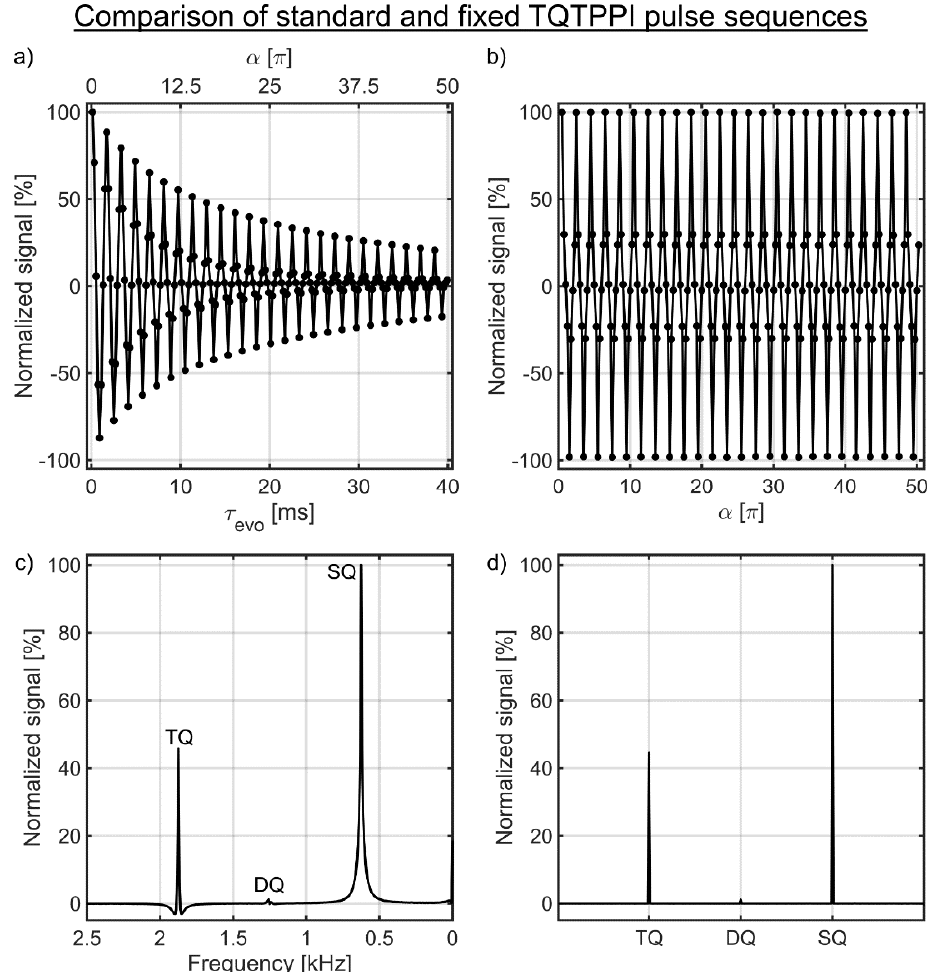
Figure 4. ( a , b ) show the standard and the fixed TQTPPI FID of the sample with 4% agarose in 134.75 mM NaCl, respectively. The corresponding standard and fixed TQTPPI spectrum are shown in ( c , d ), respectively. ( a ) The evolution time increment samples the TQ signal for a wide range of ion interaction strengths, which allows correcting the TQ signal for changes in the transverse relaxation times. The RF phase increment causes oscillations in the single-quantum (SQ) and TQ signals, which yields SQ and TQ signals at distinct frequencies after Fourier transformation. ( b ) The signal of the fixed TQTPPI FID oscillates only between the maximum and minimum signal due to the RF phase increment and a fixed evolution time. ( c ) Lorentzian functions represent the different coherences in the standard TQTPPI spectrum, while the coherences in the fixed TQTPPI spectrum are close to delta functions as shown in ( d ).